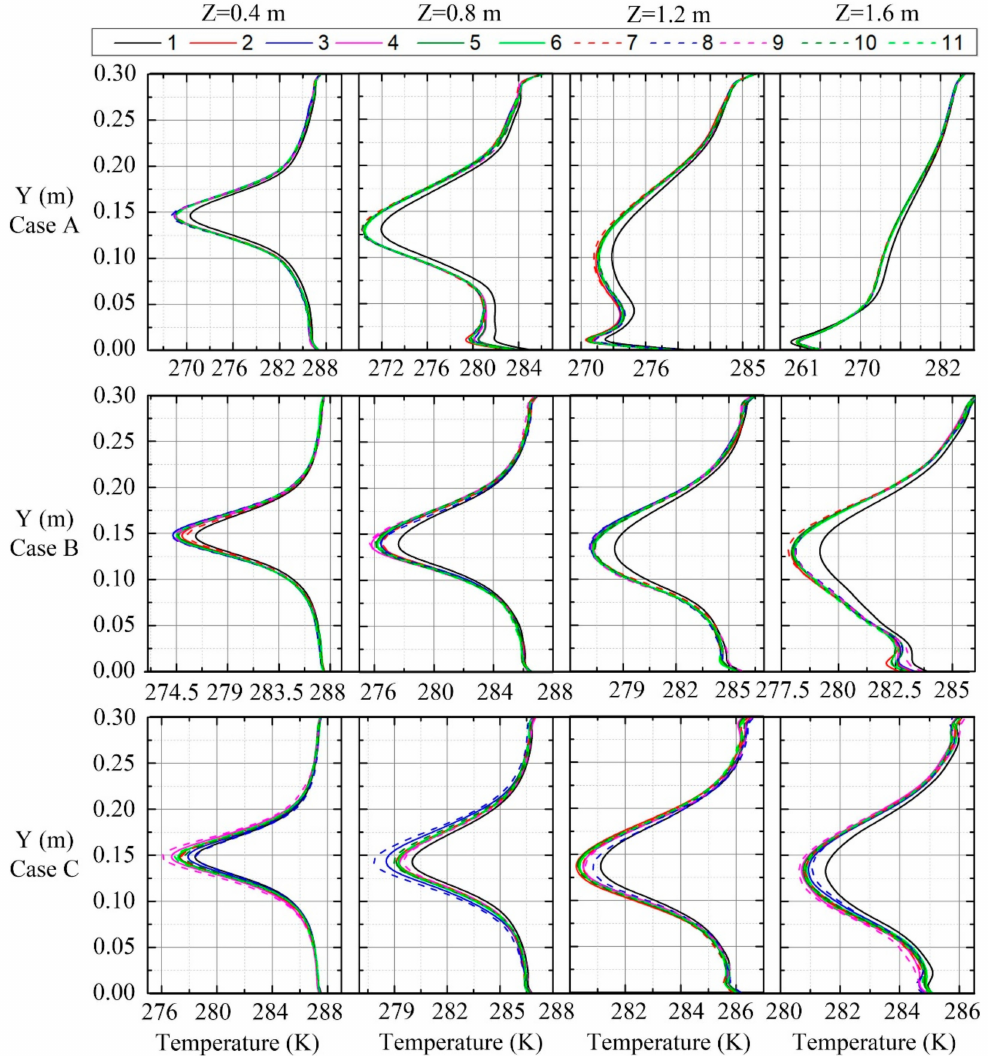
Figure 10. Temperature along vertical lines at the center